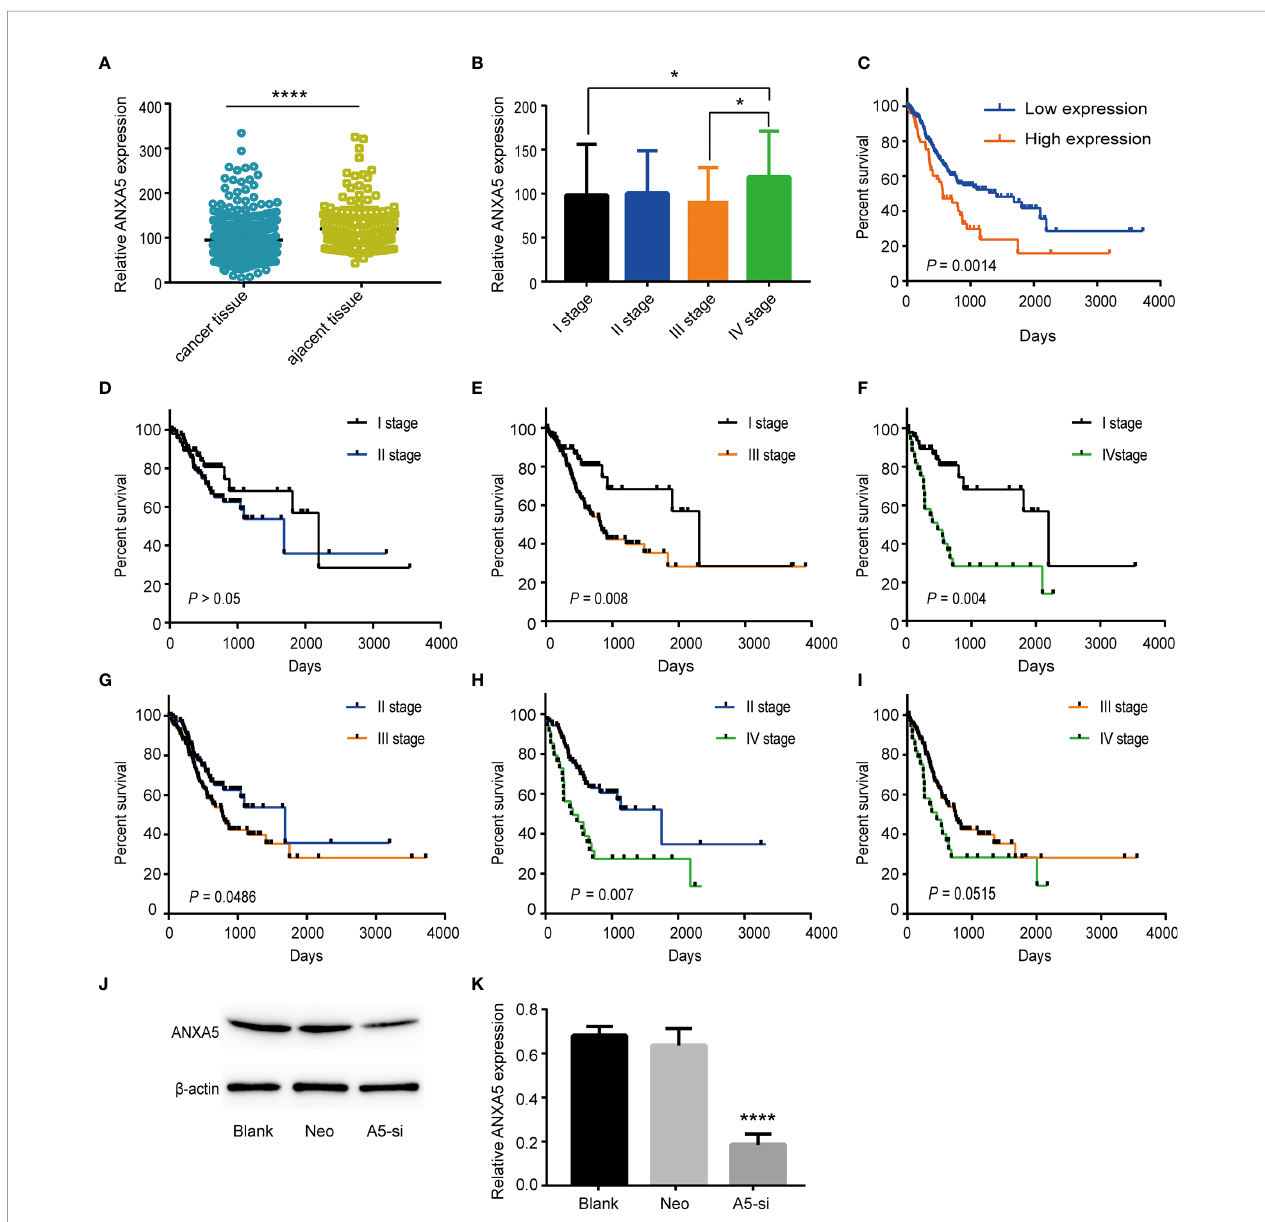
FIGURE 1 | Endogenous ANXA5 expression in gastric cancer tissues and ef fi ciency of ANXA5 interference. With the data preserved in the databases, endogenous ANXA5 expression decreased signi fi cantly in the gastric cancer tissues when compared with the adjacent normal tissue (A) . With the stage increase, ANXA5 expression decreased except stage IV which showed abnormal increased expression (B) . With the clinical stage increase, the survival rate decreased except that of stage IV (C – I) . The ANXA5 suppression ratio was examined by western blot analysis. 48 h after RNA interference, the ANXA5 suppression rate was about 78.3% (J, K) which was signi fi cantly decreased compared with that in the Neg group. * P < 0.05, **** P <